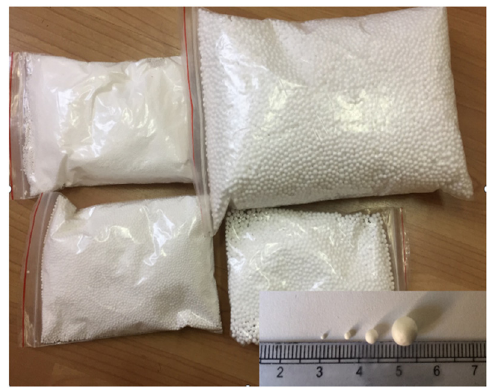
Figure 2: Four sizes of EPS beads used in